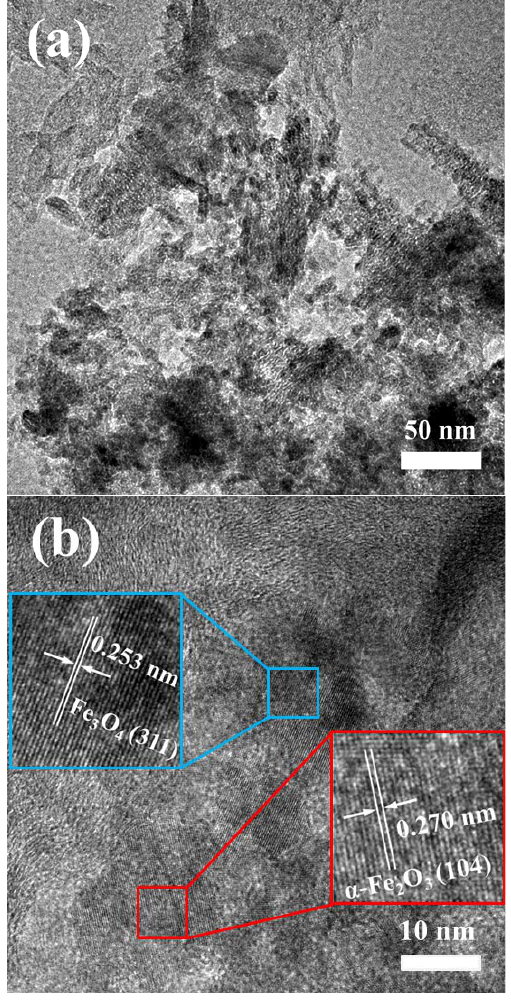
Figure 3. ( a ) TEM and ( b ) HRTEM images of CBC ‐ Fe(II). N 2 adsorption ‐ desorption isotherms of CBC, CBC ‐ Fe(III) and CBC ‐ Fe(II) were de ‐